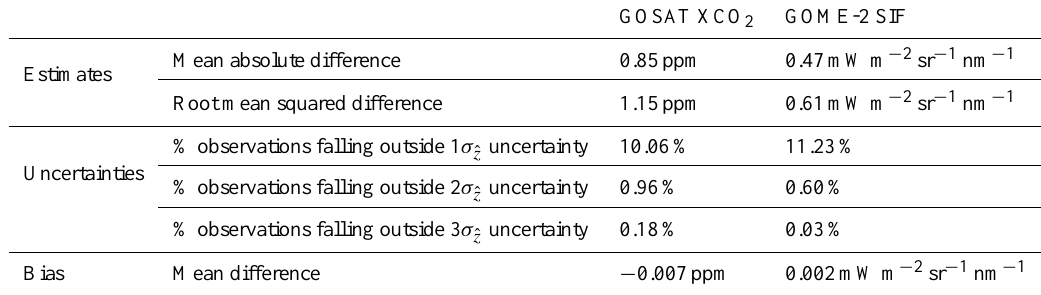
Table 1. Cross-validation results of GOSAT XCO 2 and GOME-2 SIF data sets, including mean absolute difference, root mean squared difference, percent of observations lying outside of 1, 2, and 3 standard deviations ( σ ˆ z ) of the mapping uncertainty and mean